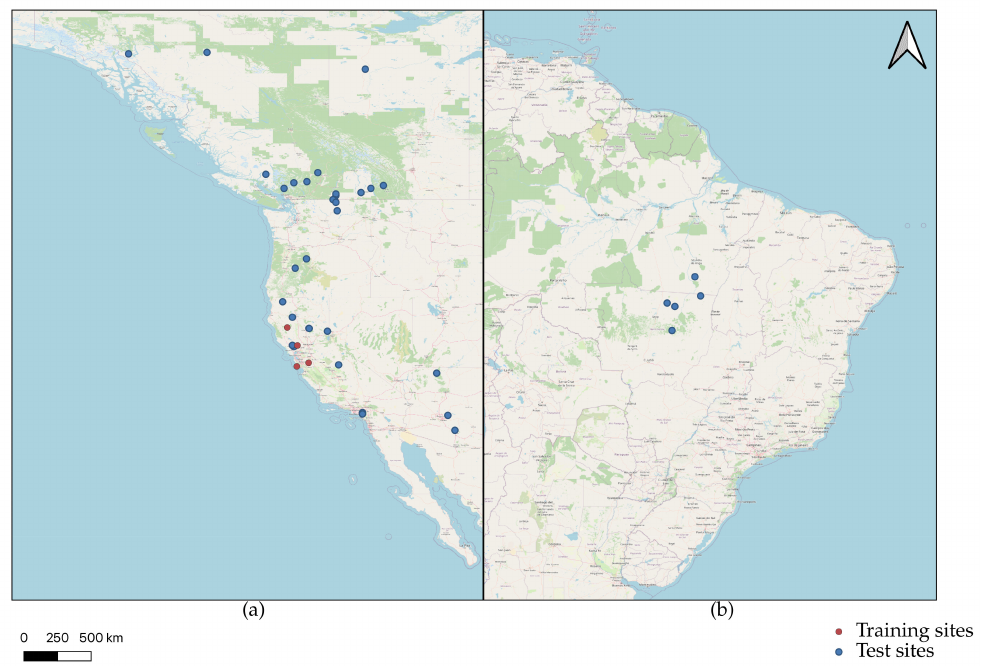
Figure 1. Study areas from North America ( a ) and South America ( b ), all the wildfire regions are generated using QGIS and overlaid on Base Map Layer in Open Street